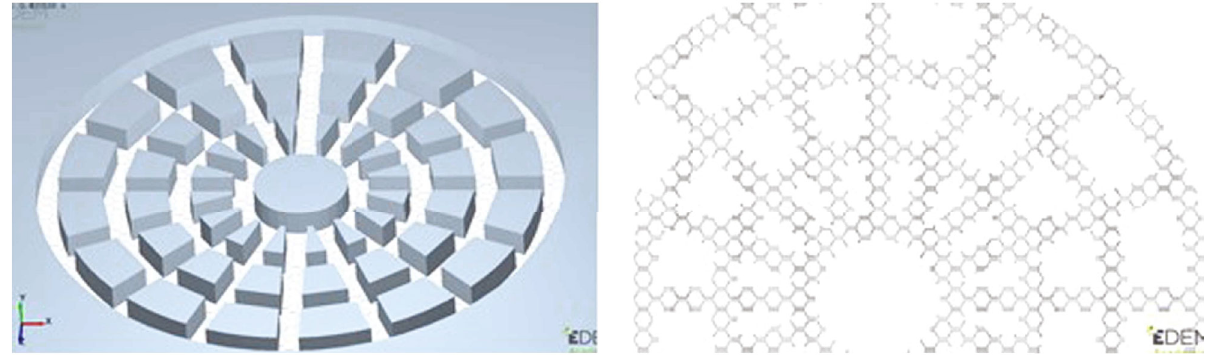
Figure 6: Honeycomb stamping die and its discrete element model after stamping.